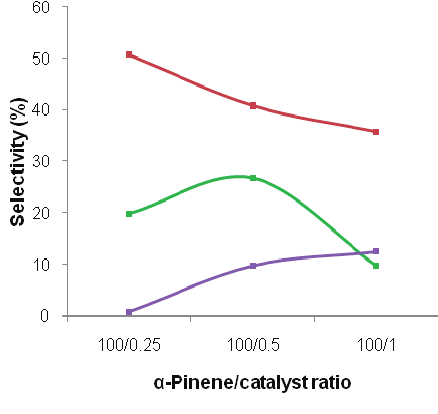
Figure 8. Effect of the catalyst concentration on the selectivity of